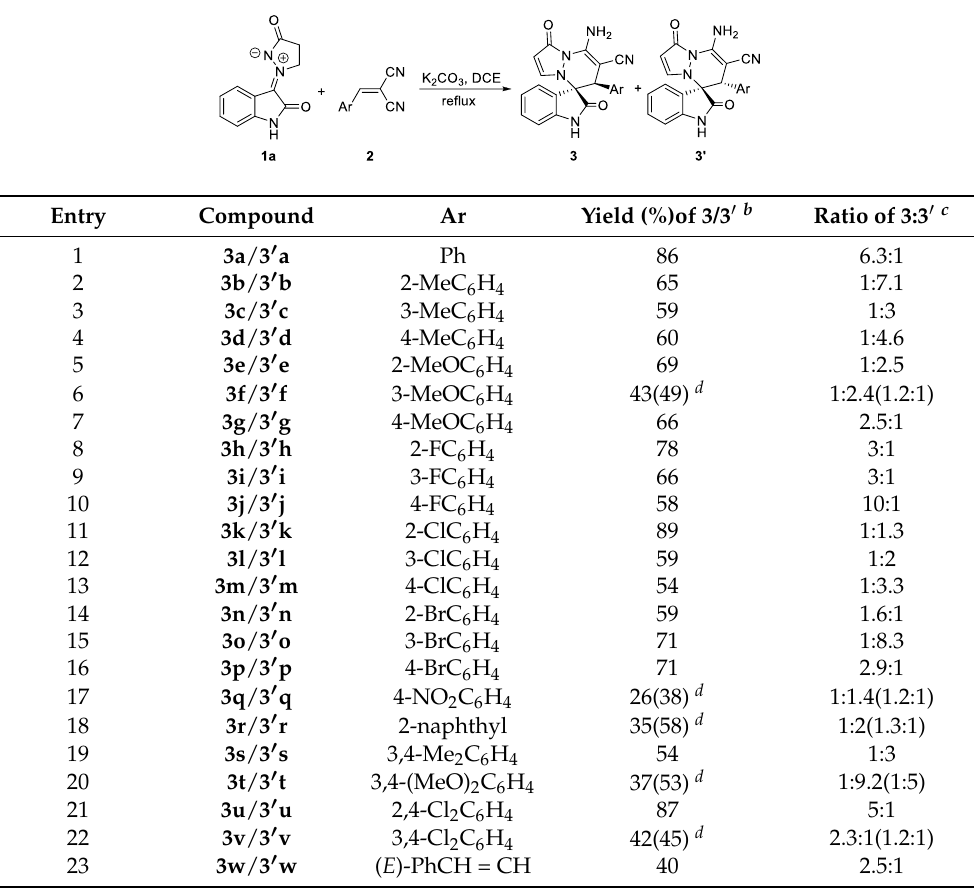
a Reaction conditions: 1a (1.0 mmol), 2a (1.1 mmol) and K yield via recrystallization or column chromatography. c The selectivity was determined by 1 H NMR. d The